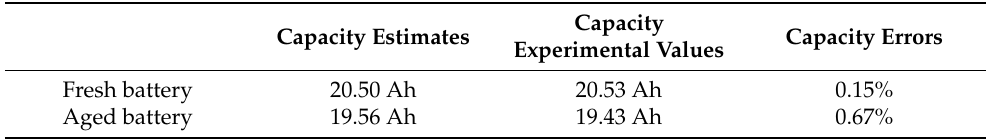
Table 3. Basic performance parameters of the